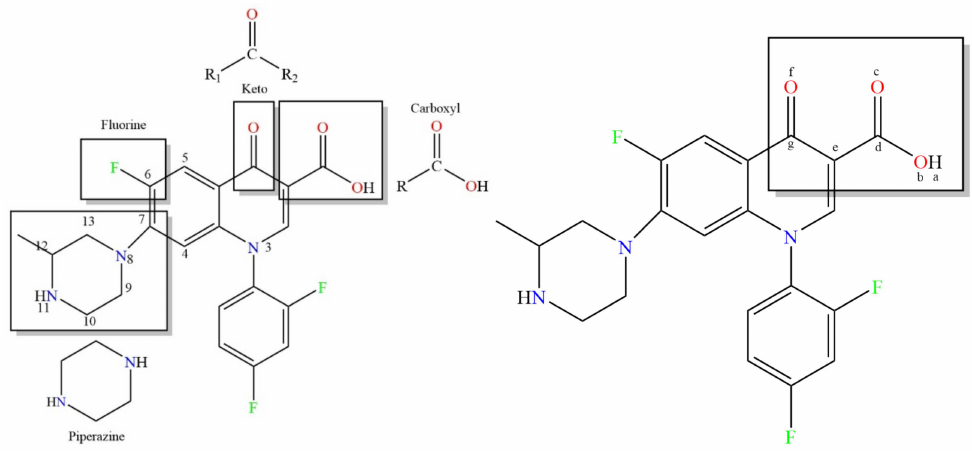
Figure 2. The molecular structure and the common skeleton of TEM. “a–f” indicate atoms H, O, O, C, O, and C, respectively, in the common